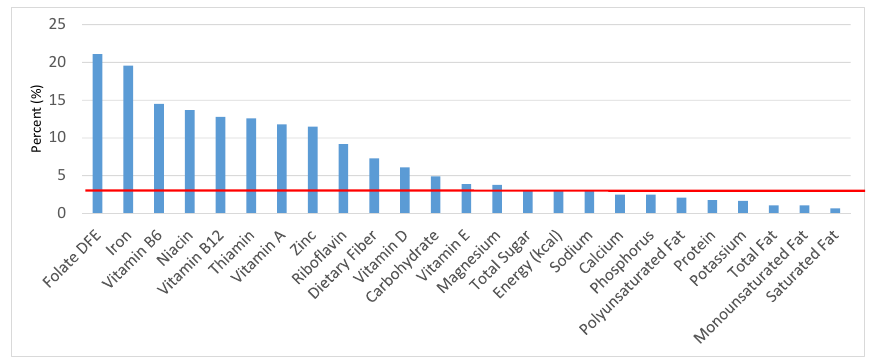
Figure 12. Ready ‐ to ‐ eat cereals as sources of energy and nutrients for children 1–3 years old ( N = 1423, daily intake data): DFE = Dietary Folate Equivalents; solid red line represents percentage of energy (kcal) provided in the diet relative to nutrients—nutrients above the red line show the grain food’s contribution to nutrient density.